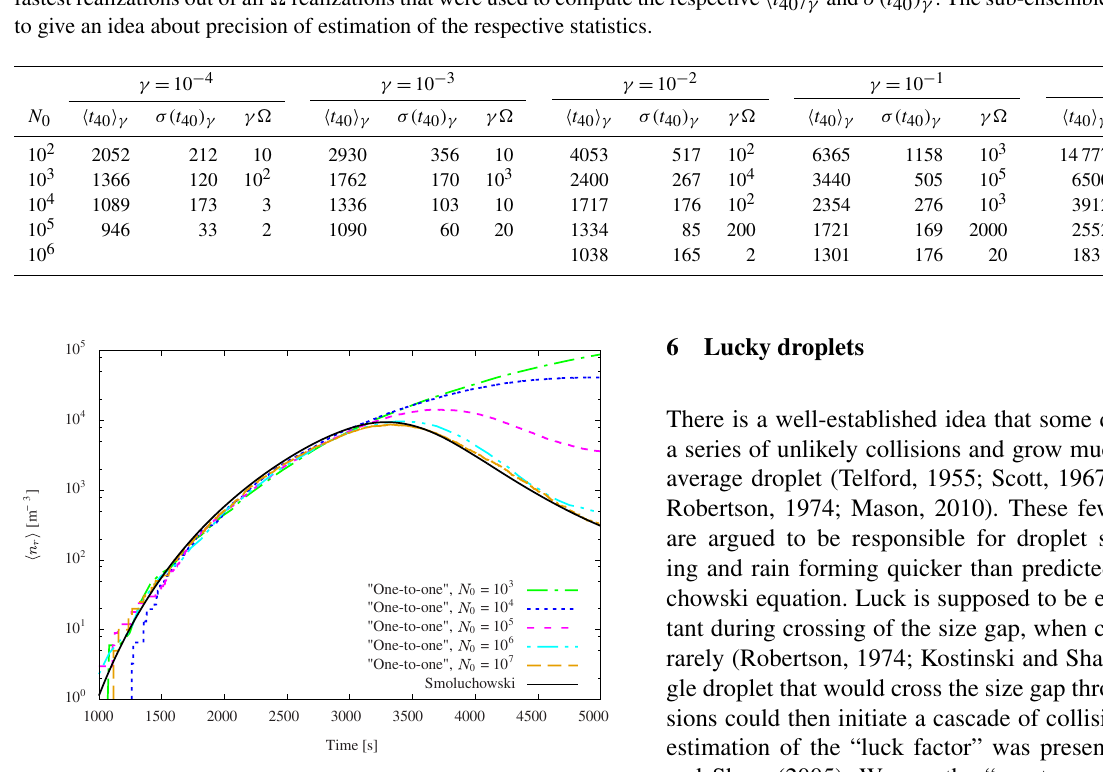
Figure 9. Mean concentration of raindrops from the same simula- tions as in Fig.